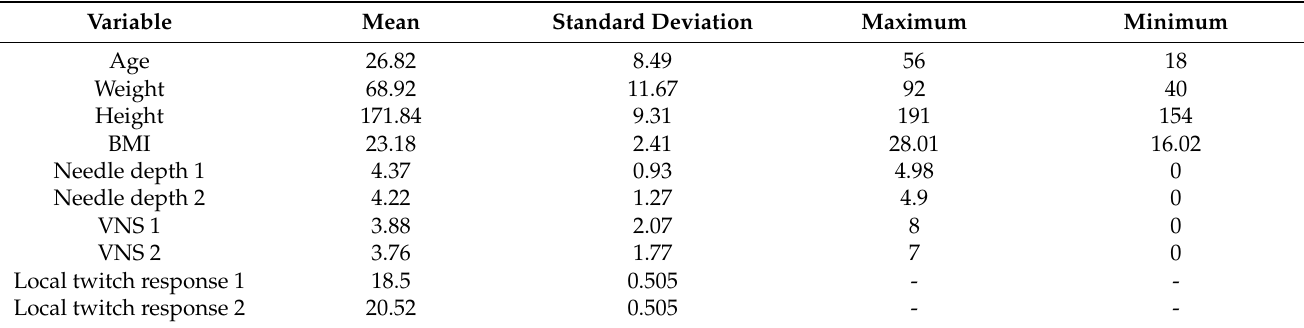
Table 1. Descriptive analysis of the dependent and independent variables .